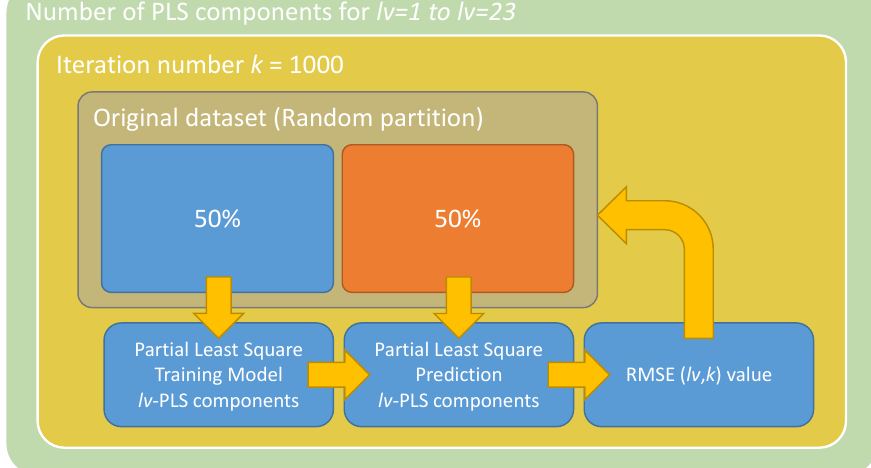
Figure 4. Diagram of the proposal methodology to develop and validate the PLS regression